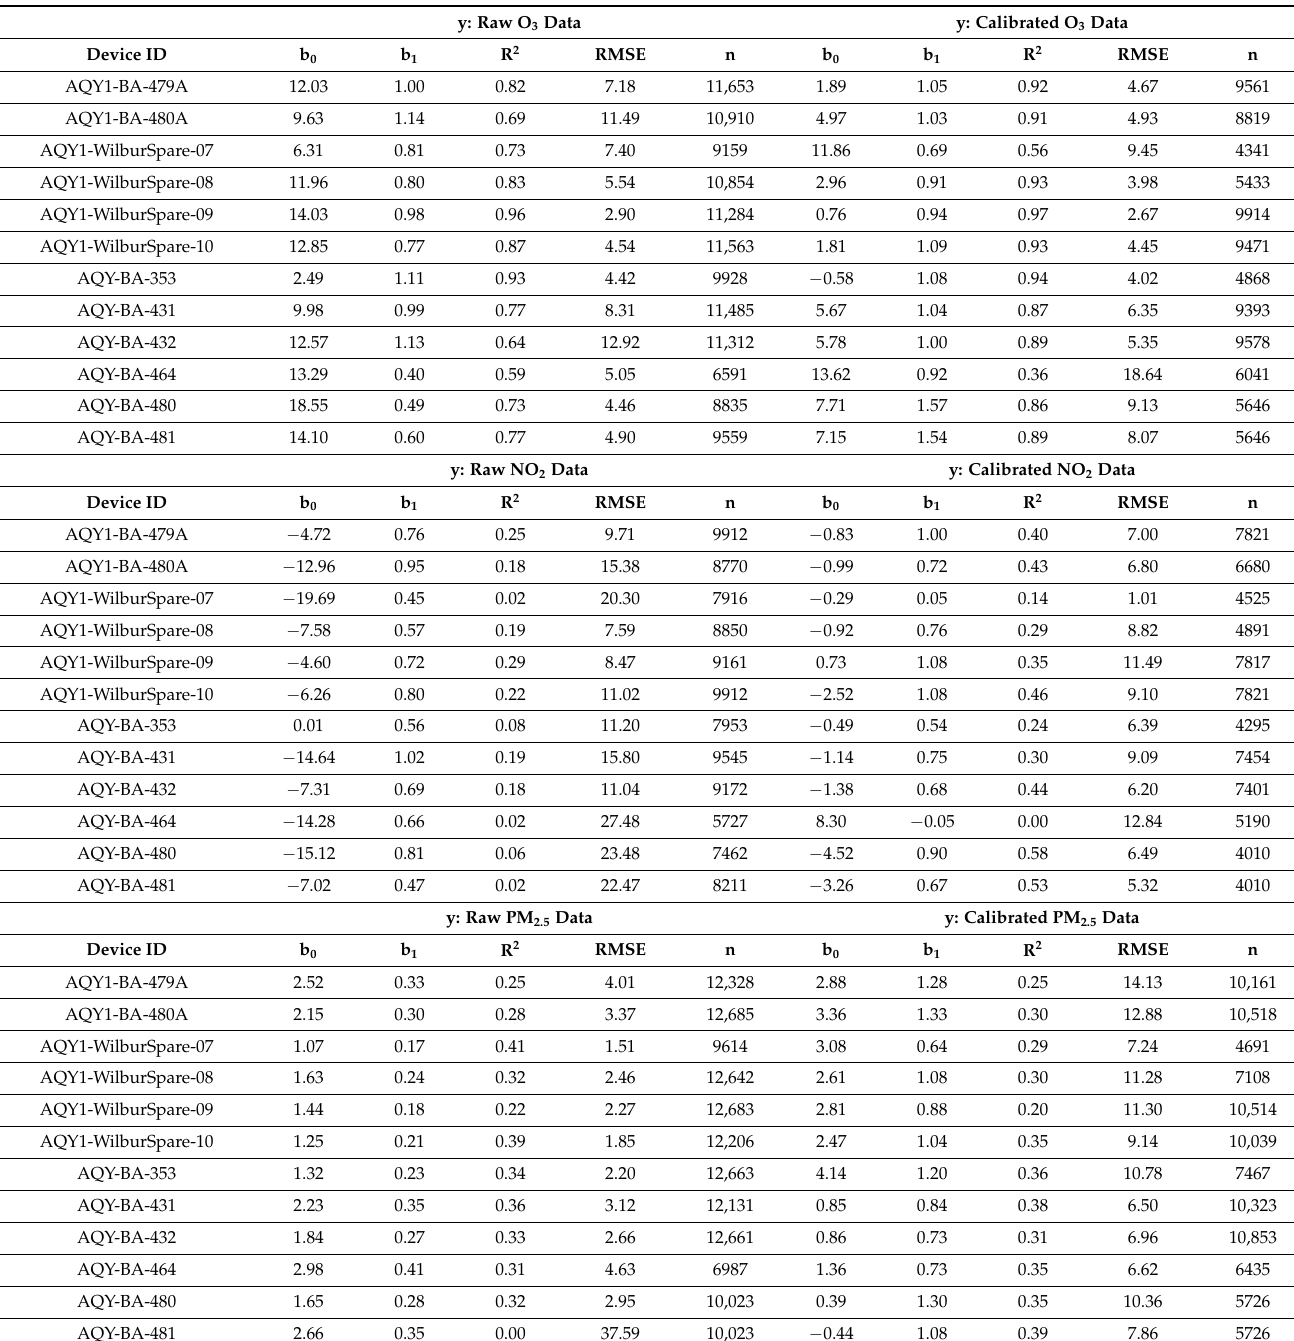
Table 3. Summary of Regression Analysis for O 3 , NO 2 , PM 2.5 , and PM 10 Data from the AQY1 Monitors. Results are shown by